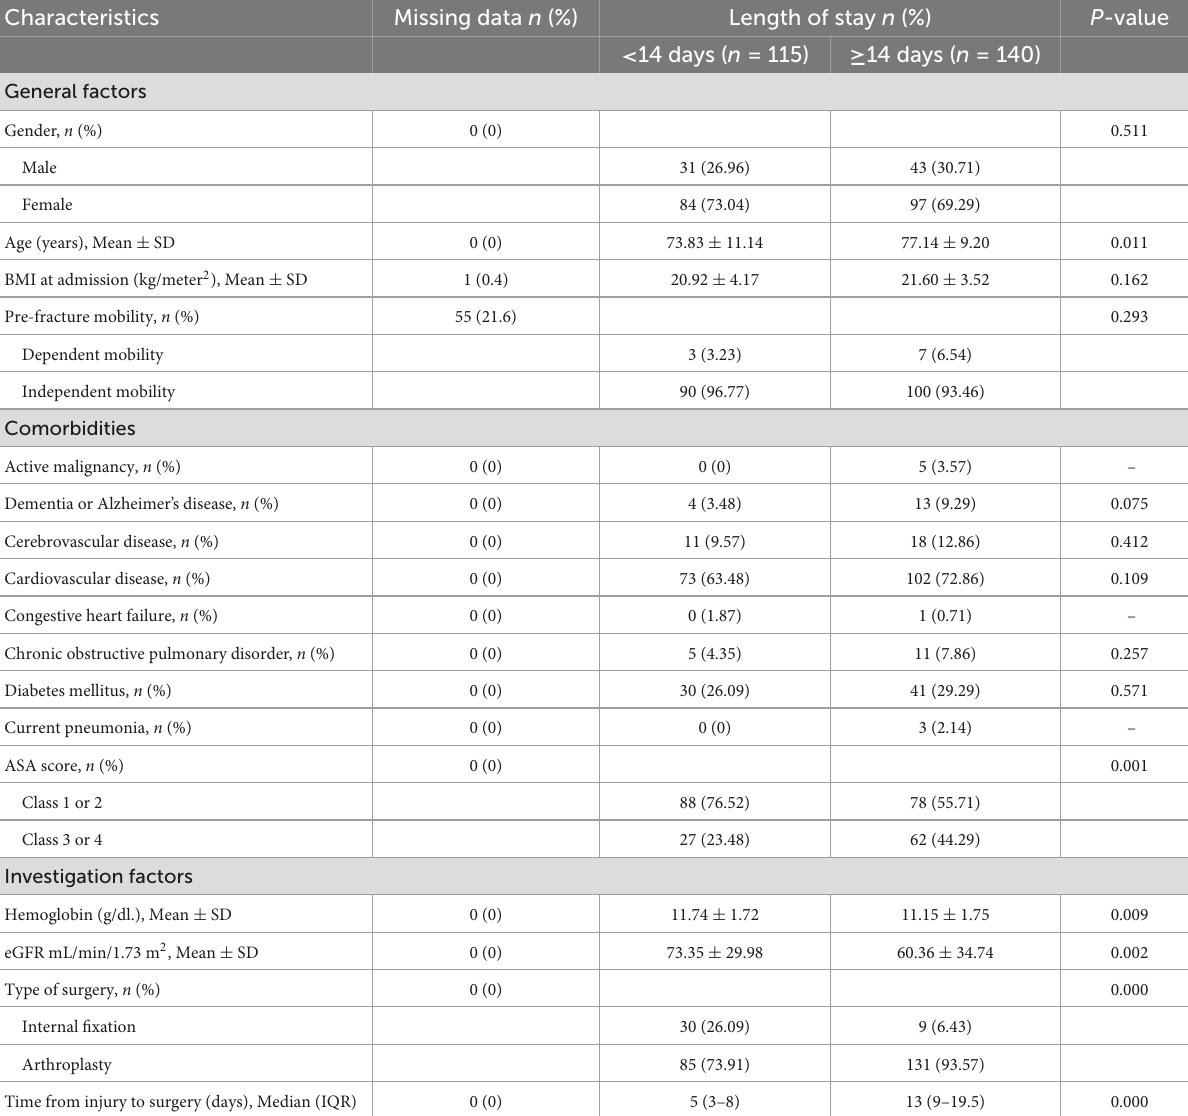
TABLE 1 Baseline clinical characteristics and candidate predictors for prolonged length of stay of patients with osteoporotic femoral neck fracture ( n = 255).